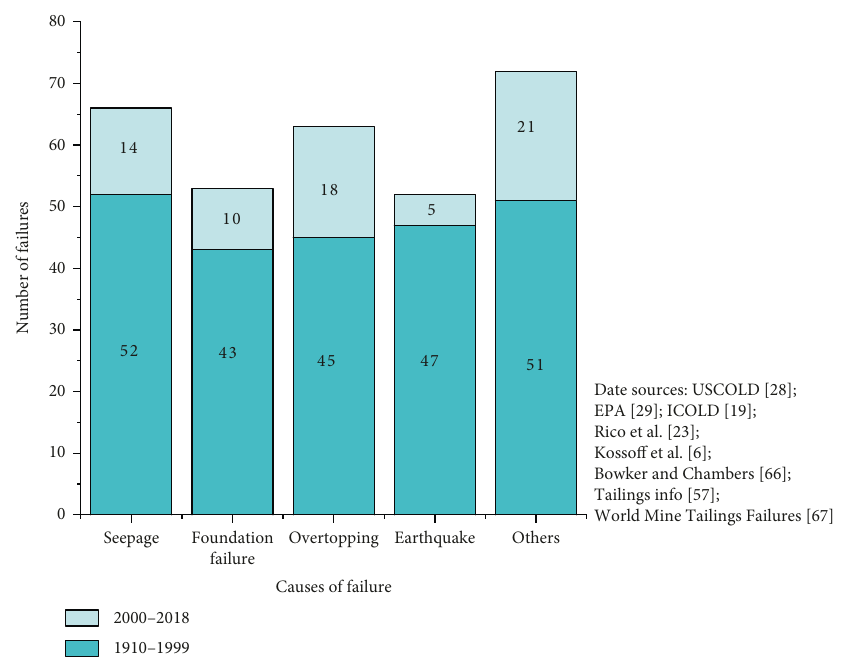
Figure 5: Failure distribution by